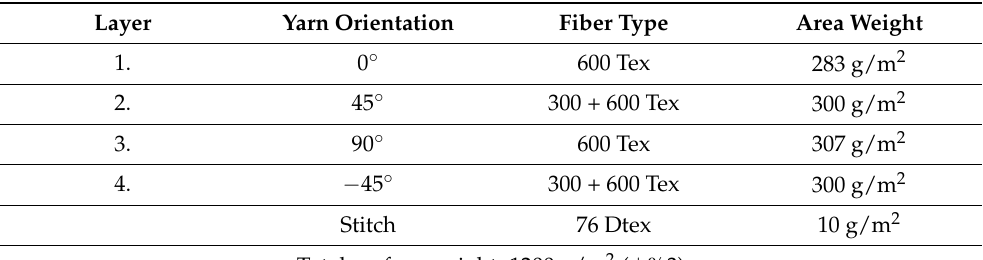
Table 1. Architecture of the glass fiber fabric